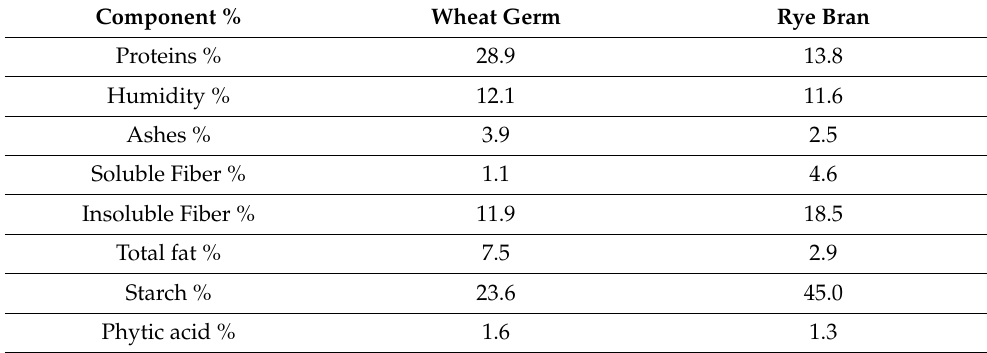
Table 1. Chemical composition of wheat germ and rye bran used in this